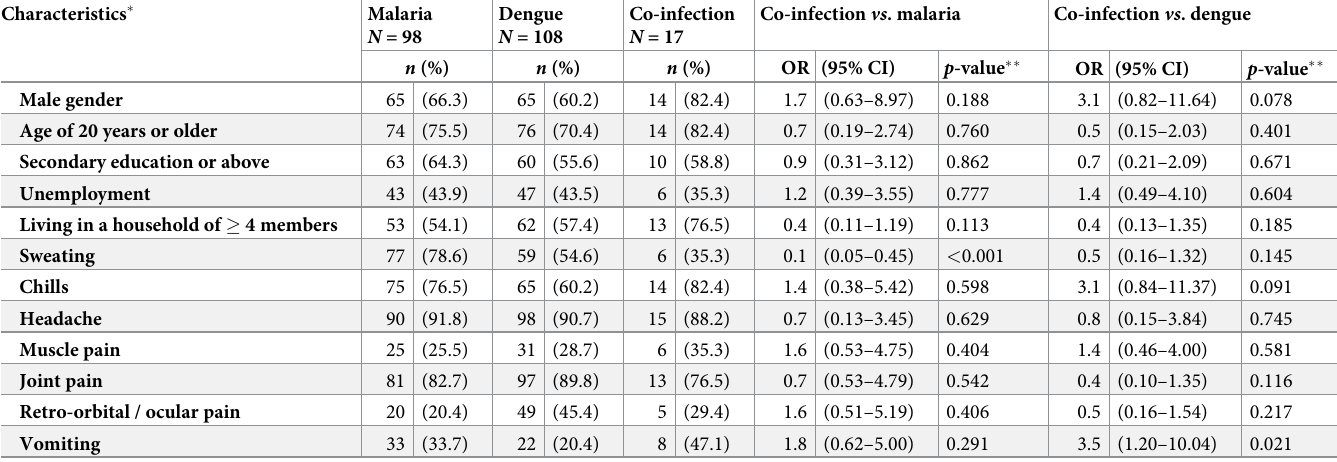
Table 3. Comparison between co-infection and mono-infection with malaria and dengue among febrile patients from Hodeidah city of Yemen in relation to certain sociodemographic and clinical characteristics (2018–2019). Characteristics